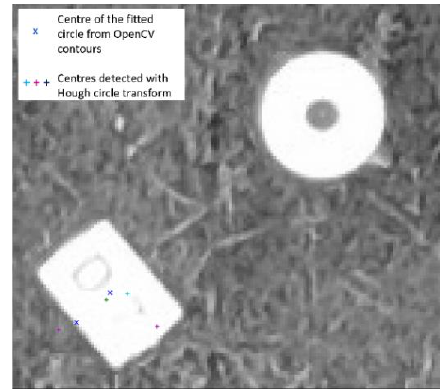
Figure 7. Example of false positives mis-detected with the OpenCV algorithm due to a relatively oblique viewing